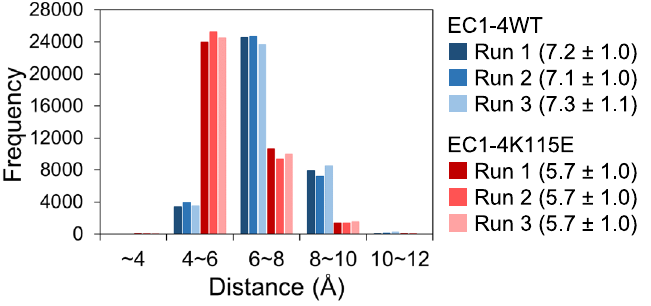
Figure 6. Distance between the center of gravity of Lys115 or Glu115 and Lys117. Means ± standard deviations from 40 to 400 ns in Å units are shown.